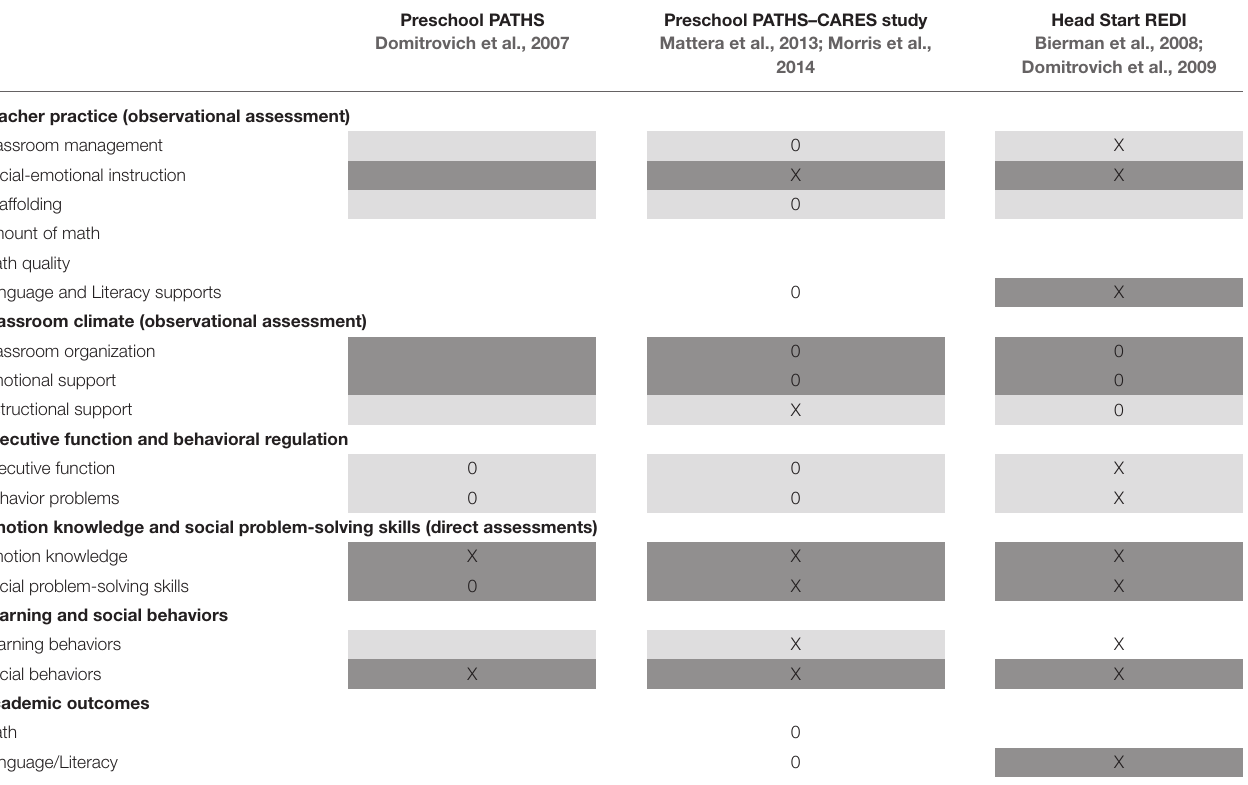
TABLE 6 | The pattern of effects on teacher and child outcomes across social-emotional learning